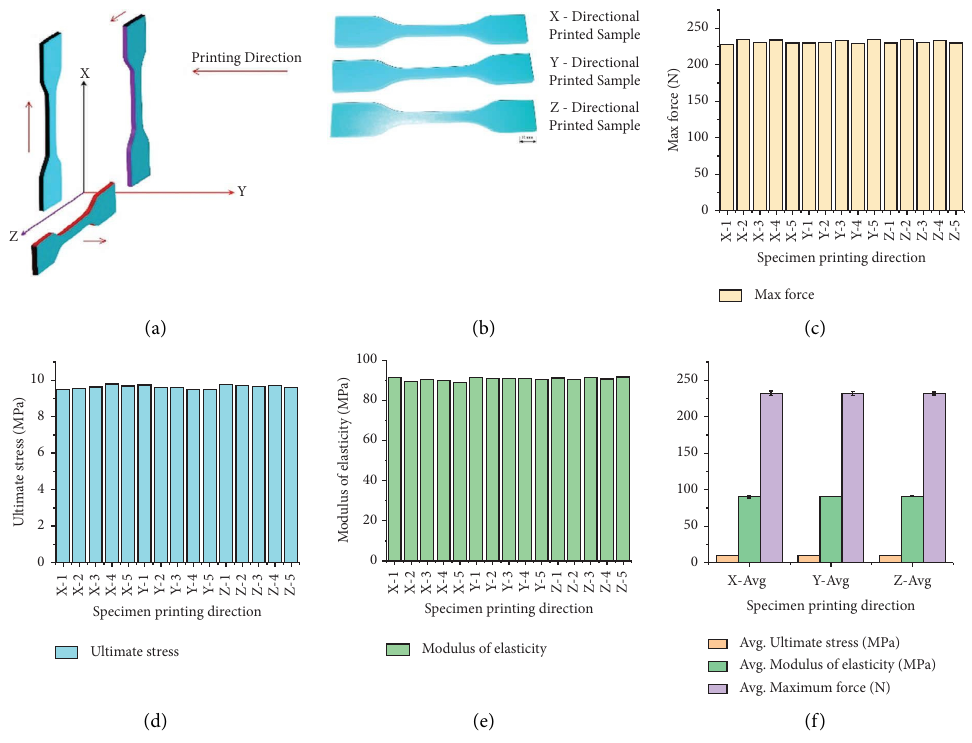
Figure 5: Photopolymer material characterization: (a) fabricated directions for sample preparation, (b) fabricated sample, (c–e) plots for maximum force, ultimate stresses, and modulus of elasticities for X , Y , and Z -directional fabricated samples, and (f) the average properties with standard deviation for the photopolymer Table 1: Te base material properties of the resin. Specifcation